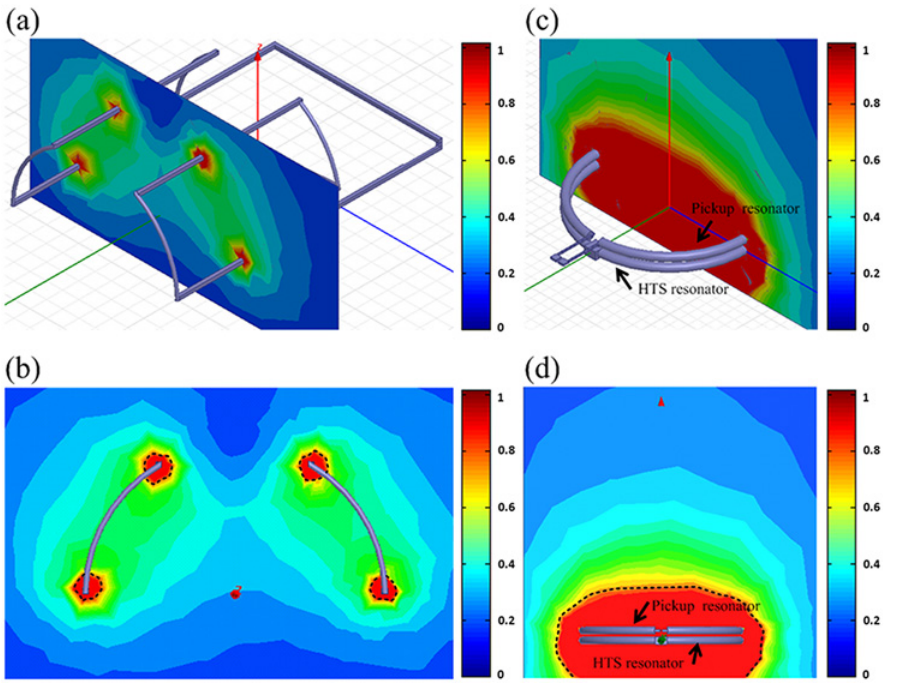
Fig 3. Ansoft HFSS simulated results of the QD surface resonator and the HTS surface resonators. (a) The 3D view of the QD surface resonator at 300K. (b) The X-axis view of the QD surface resonator at 300K. (c) The 3D view of the HTS surface resonators at 77K. (d) The X-axis view of the HTS surface resonators at 77K. Table 2. The SNR obtained from different kind of surface resonators. The HTS surface resonator The QD surface resonator The copper surface resonator